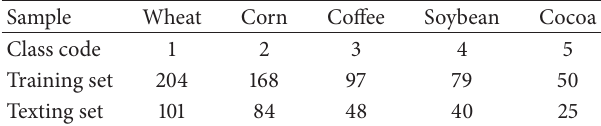
Table 1: Training set and testing